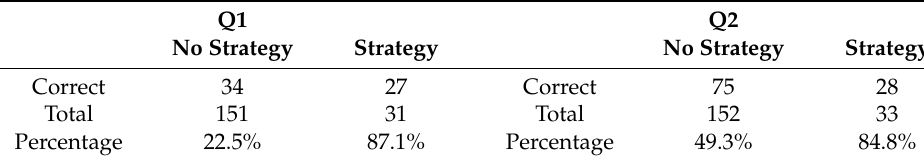
Table 4. Correct responses percentage, according to strategy or not, in Q1 and Q2.